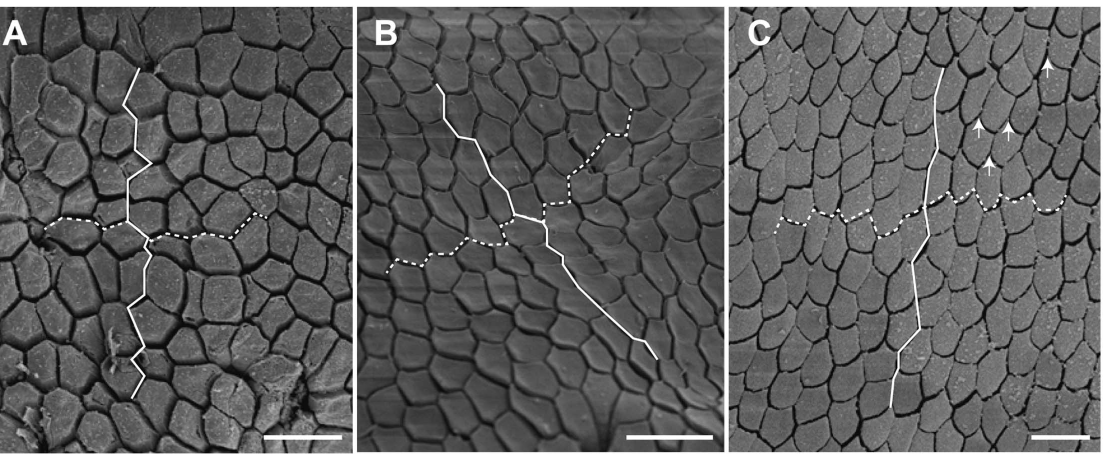
Figure 6. Scanning electron micrographs of toe pad epithelia in different frog species. (A) the tree frog R. pardalis , (B) the torrent frog S. guttatus near the edge of pad, and (C) the torrent frog, Odorrana hosii . White solid lines illustrate shortest routes to the edge of pad. White dashed lines are routes across the pad. Arrows show examples of the pointed ends of the epithelial cells of O. hosii . Scale bars: 20 m m.